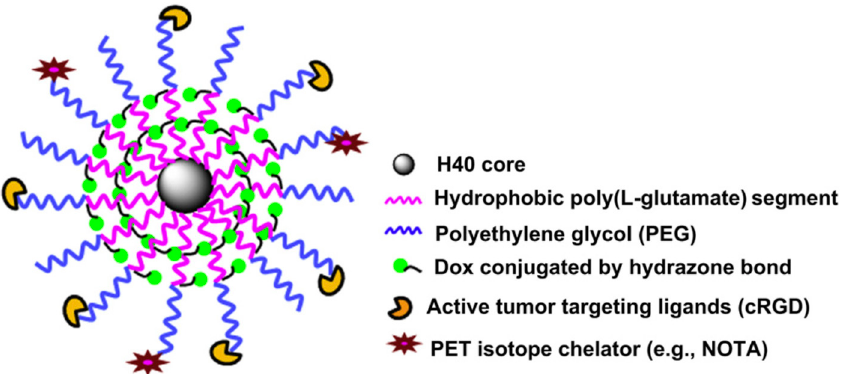
Figure 13. H40-DOX-cRGD star-shaped nanocarriers for tumor-targeted drug delivery and PET imaging [50].